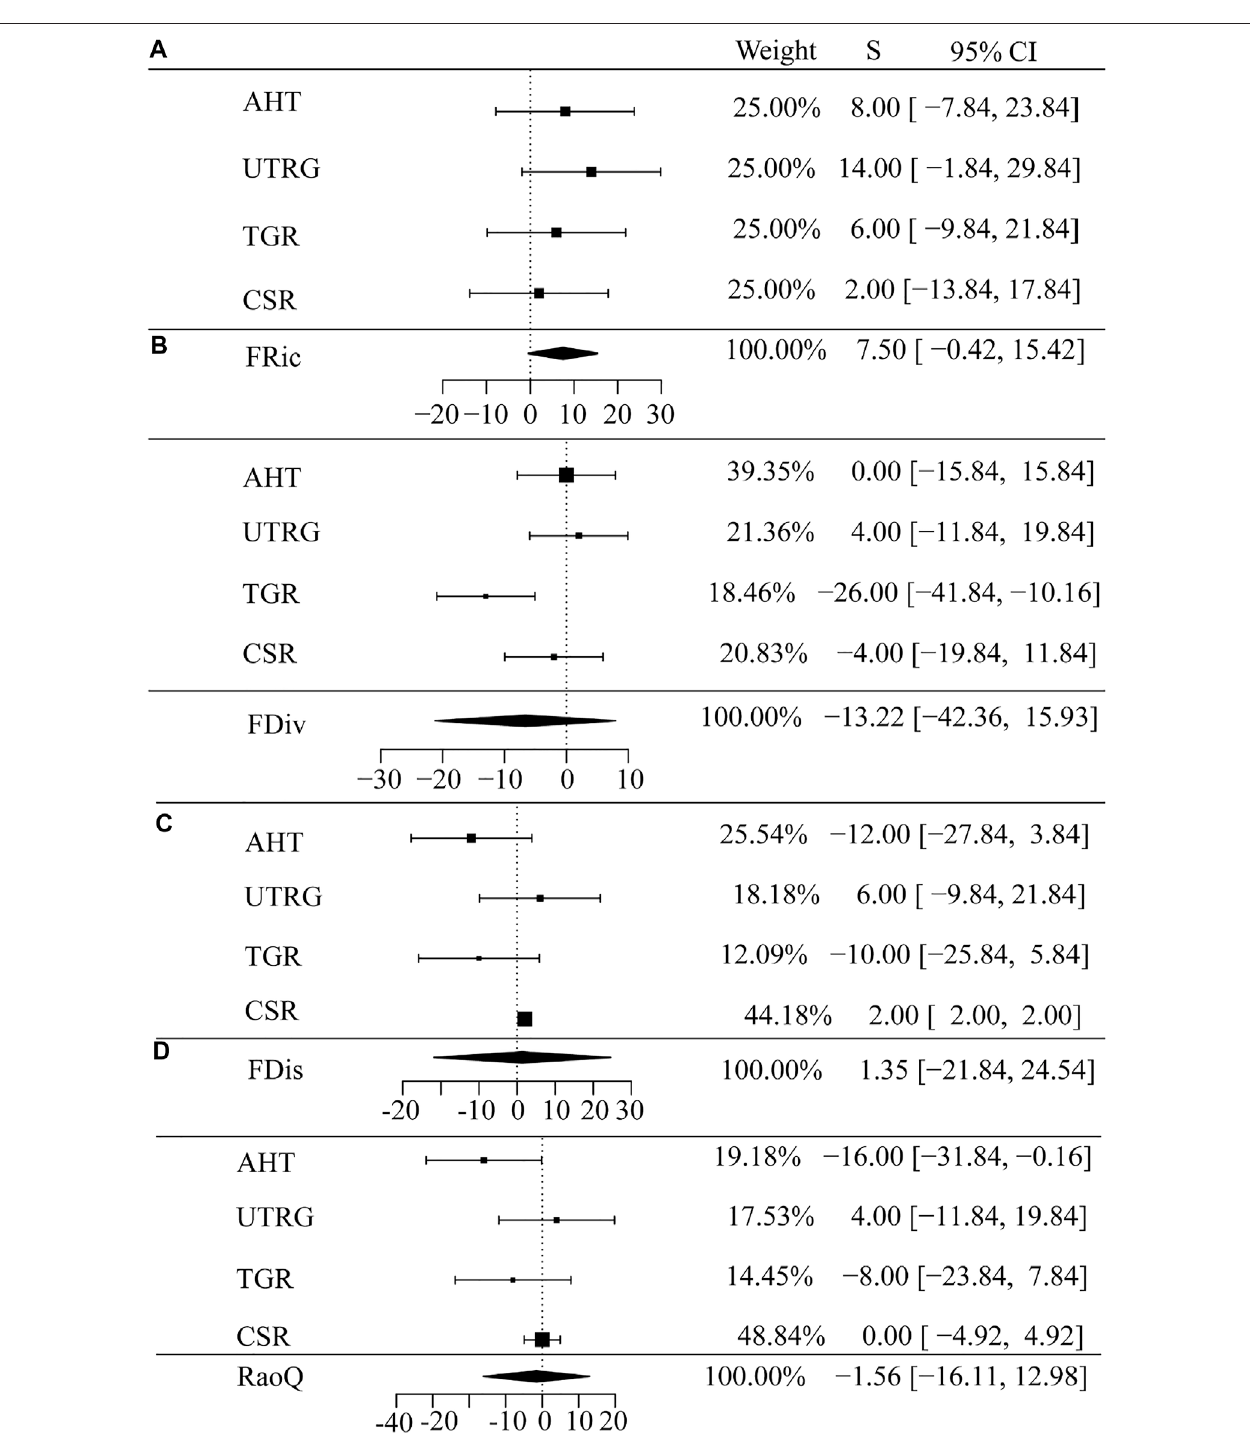
FIGURE5| Temporalchangesinfunctionaldiversityof fi shcommunitiesindifferenthabitattypesintheupperreachesoftheYangtzeRiver. (A) Functionalrichness; (B) Functional divergence; (C) Functional dispersion; (D) Rao ’ s quadratic entropy index.